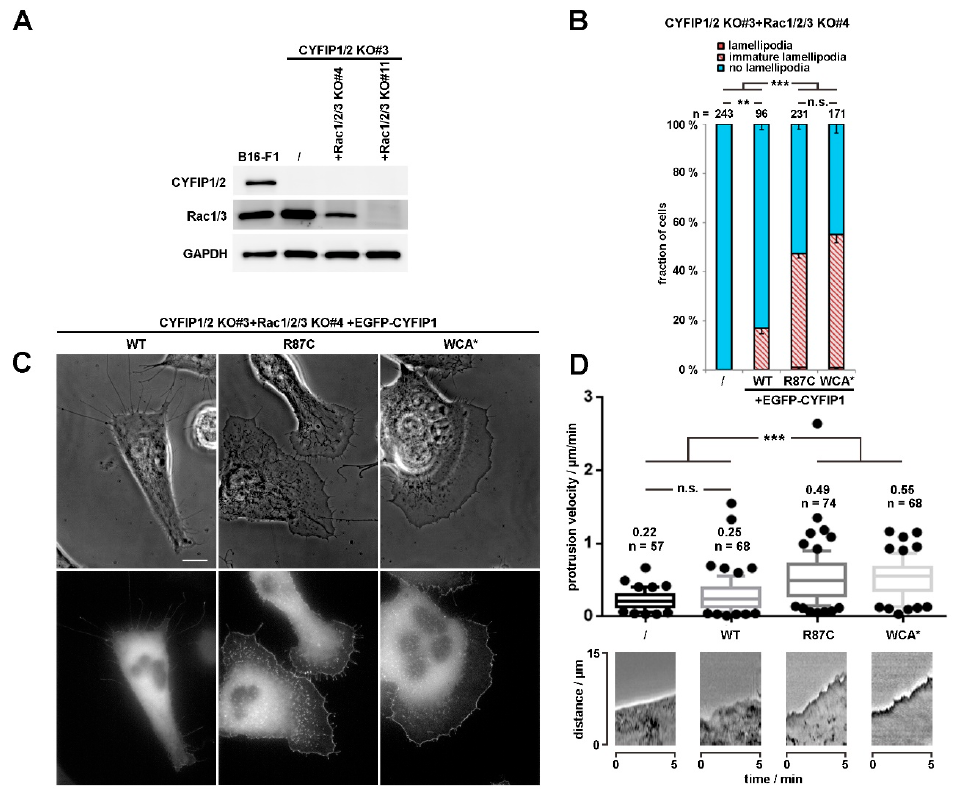
Figure 2. R87C mutation in CYFIP enhances lamellipodium protrusion at low Rac GTPase levels. ( A ) Western blotting of distinct cell lines to probe for expression levels of endogenous CYFIP and/or Rac GTPases. ( B ) Quantification of lamellipodia formation in B16-F1 CYFIP1/2+Rac1/2/3 KO cells (clone #3/4), harboring low Rac expression and transfected with indicated EGFP-tagged CYFIP1 constructs, as described in Figure 1A. Statistical significance was assessed by two-sample, two-sided t-test. n.s.: not statistically significant; ** p < 0.01; *** p < 0.001 ( C ) Live cell imaging of CYFIP1/2+Rac1/2/3 KO cells (clone #3/4) expressing EGFP-tagged CYFIP1 constructs. Upper panels show phase contrast images, and bottom panels EGFP fluorescence. Scale bar, 10 µm. ( D ) Quantification of cell edge advancement. n gives the number of cells analyzed. Box and whisker plots represent data as follows: boxes correspond to 50% of all data points (25–75%), and whiskers to 80% (10–90%). Lines and numbers above boxes correspond to medians. Statistical significance was assessed by non-parametric, Mann-Whitney-Rank-Sum test, n.s.: not statistically significant; *** p < 0.001. Bottom part shows representative